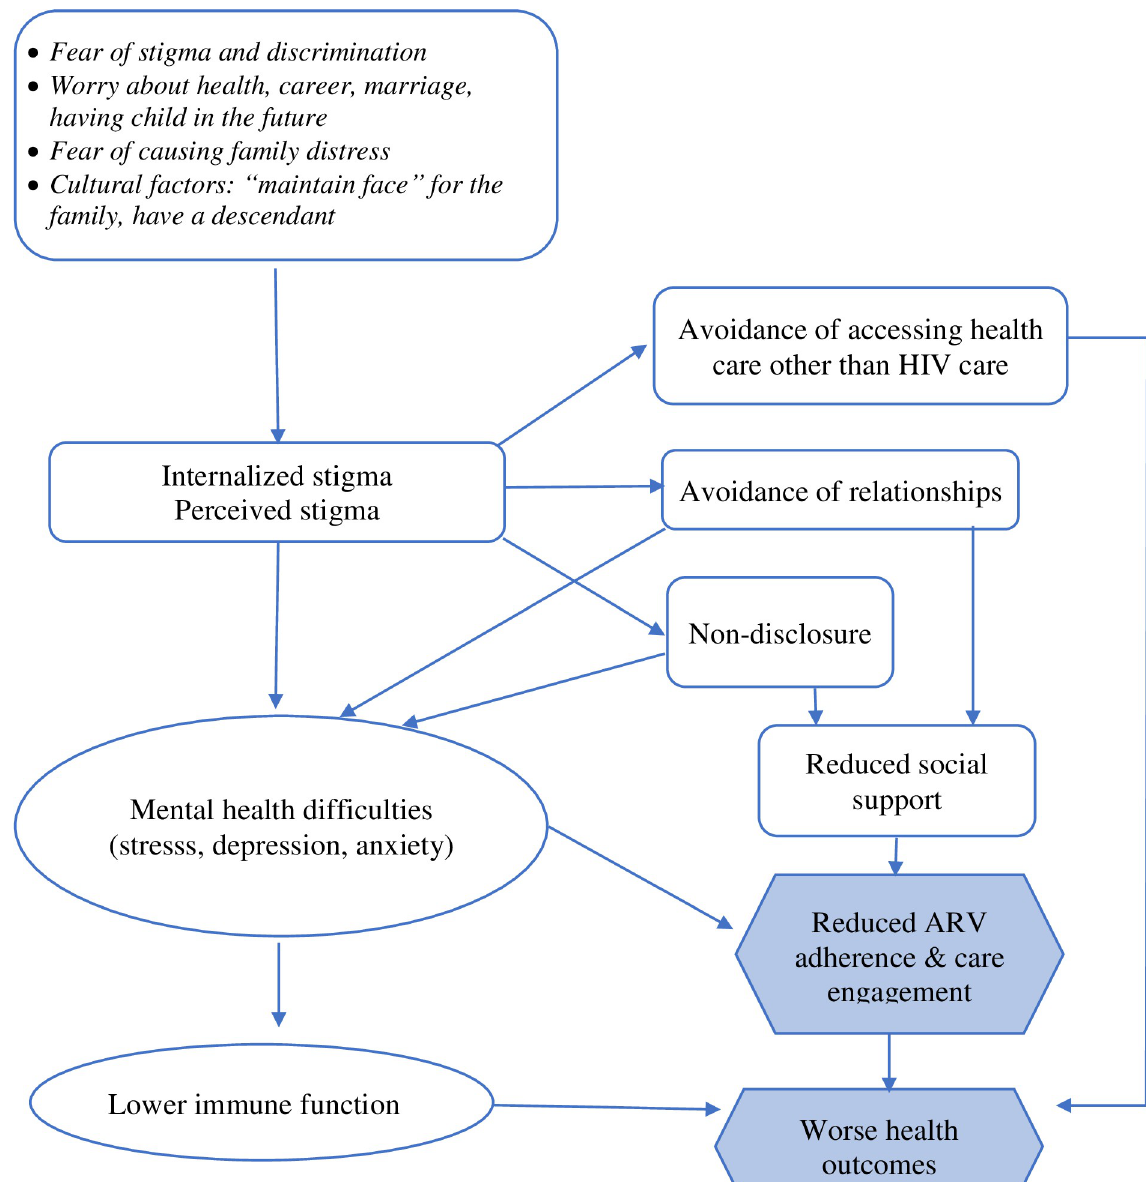
Fig 1. Summary model for the impact of stigma for youth living with HIV in Vietnam. interactions between HIV-related stigma, coping strategies, and ART adherence, care engage- ment and health outcomes (Fig 1). The model portrays the mechanisms among HIV-related stigma, its coping strategies, and ART adherence, care engagement and health outcomes. The factors contributing to internalized and perceived stigma of YLHIV are the fear of stigma and discrimination, worries about health, career, marriage, having children in the future, the fear of causing family distress, the pressures to keep “the name” for the family, and have a descen- dant. To cope with these stigmas, many YLHIV used avoidant coping strategies including non-disclosure, avoidance of romantic relationships, and avoidance of health care. The